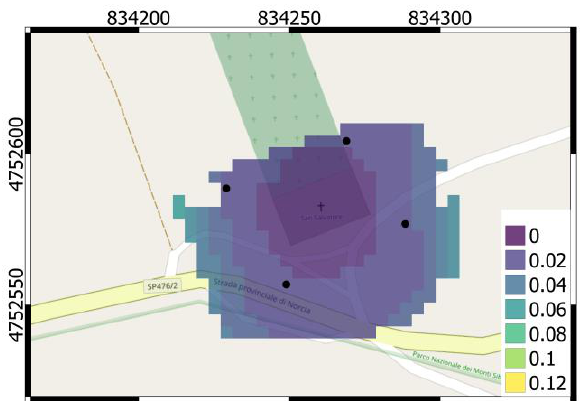
Figure 11. Estimated precisions [m] along X